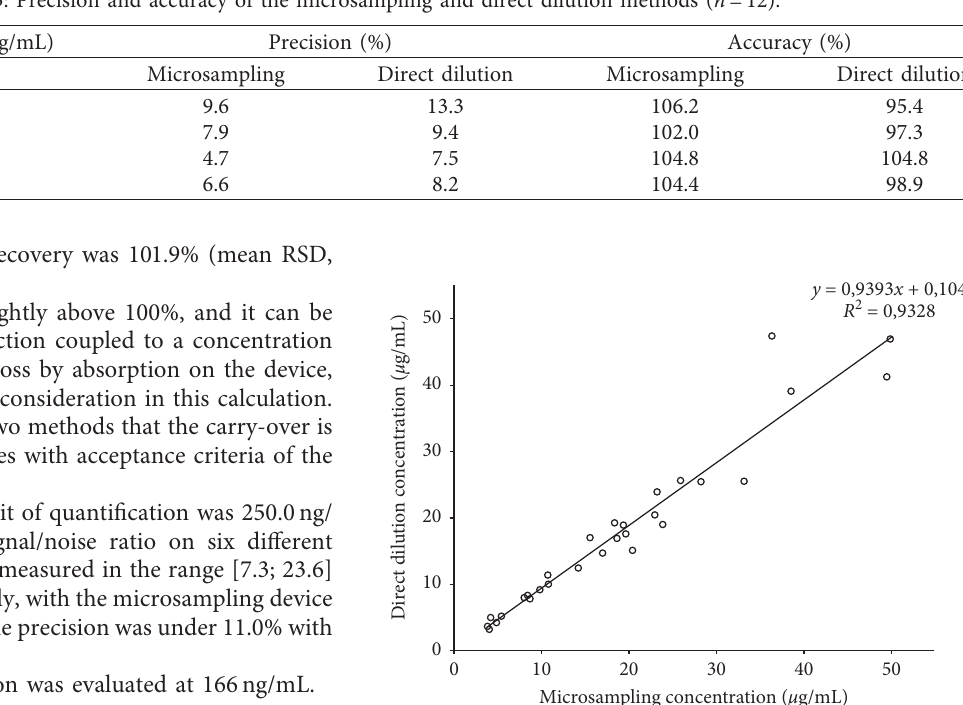
Figure 2: Concentrations of doxycycline in urine samples from workers under chemoprophylaxis quantified after direct dilution versus microsampling